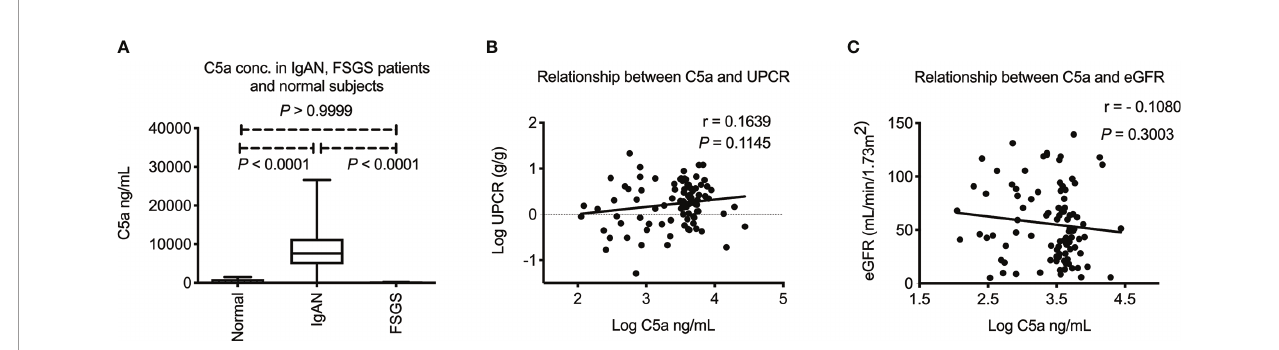
FIGURE 1 | Plasma C5a in IgA nephropathy patients. (A) Plasma C5a concentration was signi fi cantly higher in IgAN patients than FSGS patients or healthy subjects (both P < 0.0001). There was no difference of plasma C5a between FSGS patients and normal subjects. ( P > 0.9999) (B) Plasma C5a level did not correlate with level of proteinuria in IgAN. (C) Plasma C5a level did not correlate with renal function. UPCR, urinary protein to creatinine ratio. eGFR, estimated glomerular fi ltration rate. FSGS, focal